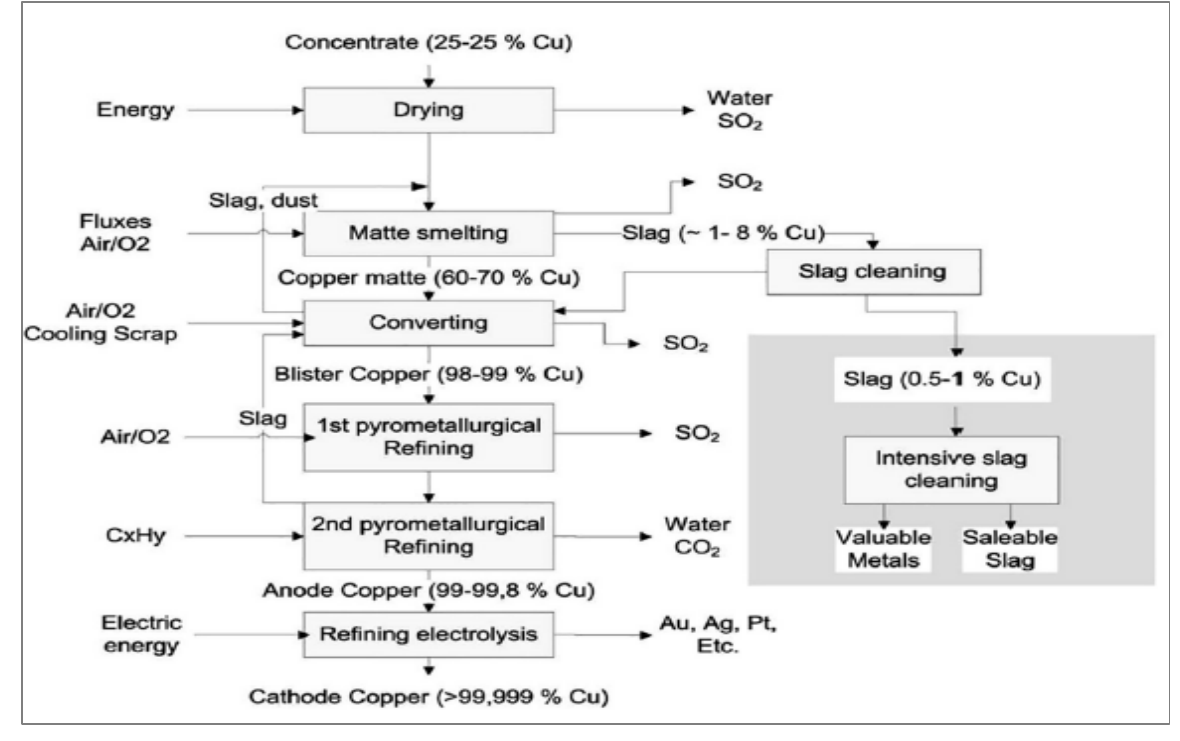
Figure 1. Flow Chart of CPS Extraction [33].